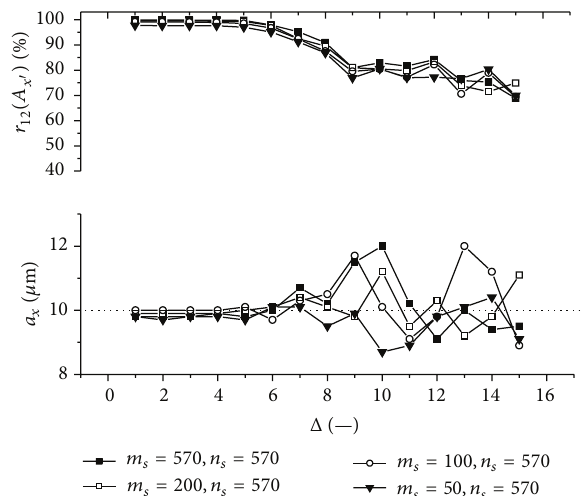
Figure 13: The evaluated object’s translation component 𝑎 𝑥 as well as the maximum 𝑟 12 (𝐴 𝑥 󸀠 ) of the 1D normalized cross-correlation function of intensity signals 𝐼 1 and 𝐼 2 acquired from decimated 2D intensity signals of various size as a function of the factor Δ . Mean speckle sizes are 𝛼 𝑥 󸀠 = 133.6 𝜇 m and 𝛼 𝑦 󸀠 = 117.7 𝜇 m. The object is translated by 𝑎 𝑥 = 10 𝜇 m and 𝑎 𝑦 = 10 𝜇 m.